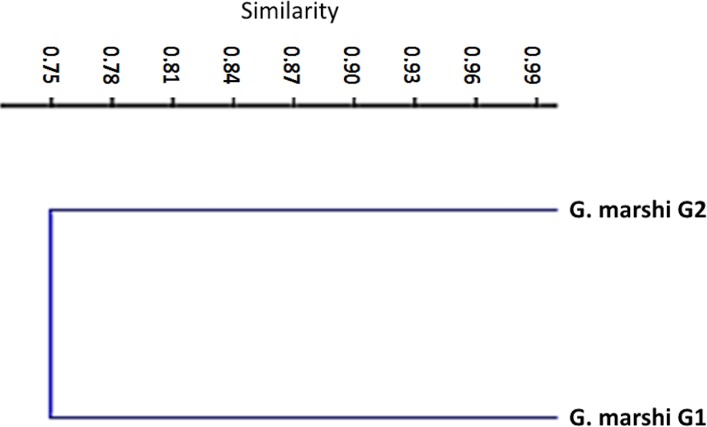
Jaccard dendrogram for measure similitude between the two groups of G. marshi.